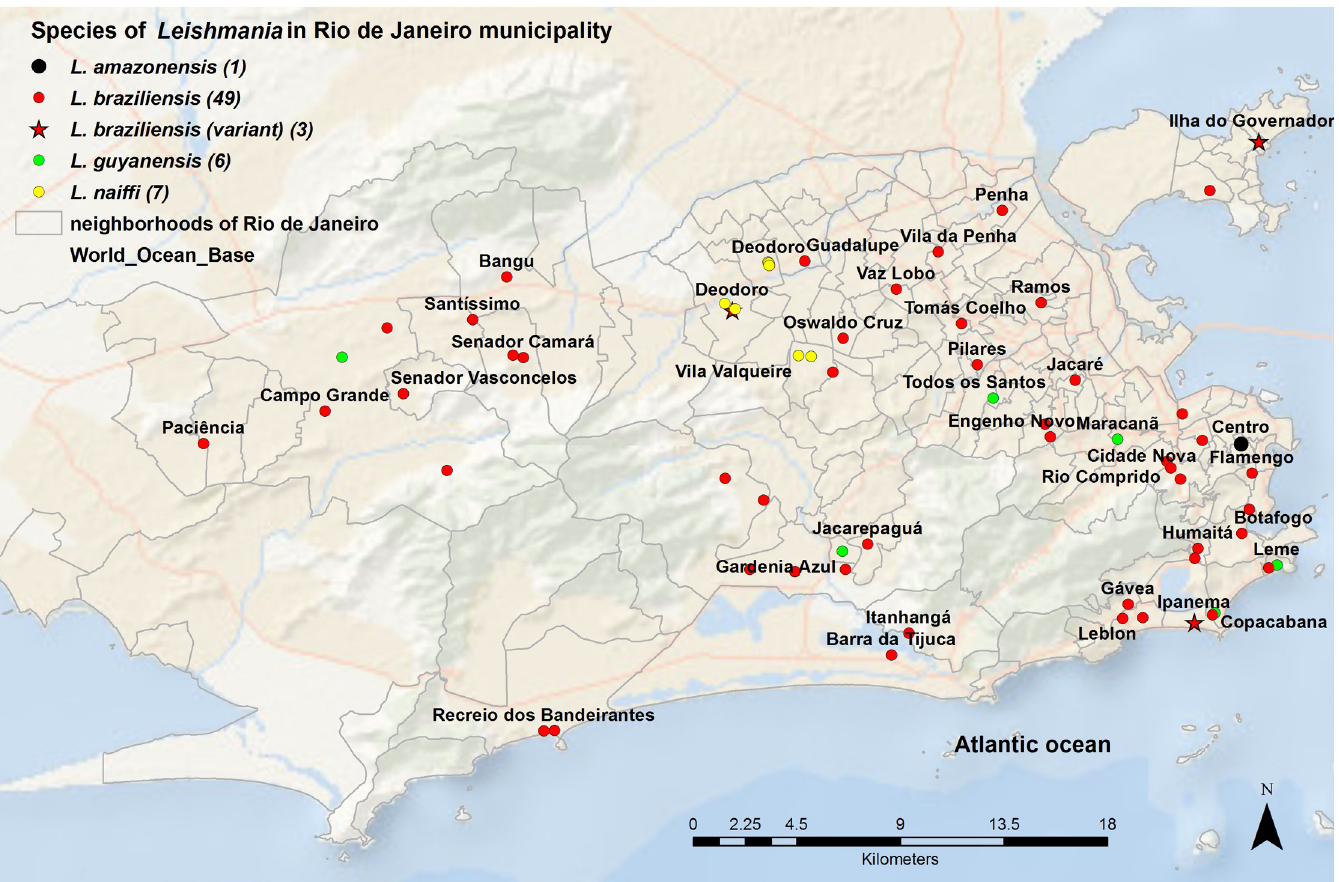
Fig 3. Species of Leishmania in Rio de Janeiro (RJ) municipality. The 66 species of Leishmania identified were plotted on the map by neighborhoods of RJ municipality, according to the residence address of the patients in RJ municipality. This map was created using ArcGIS 9.1 software and cartographic bases obtained from the Brazilian Institute of Geography and Statistics